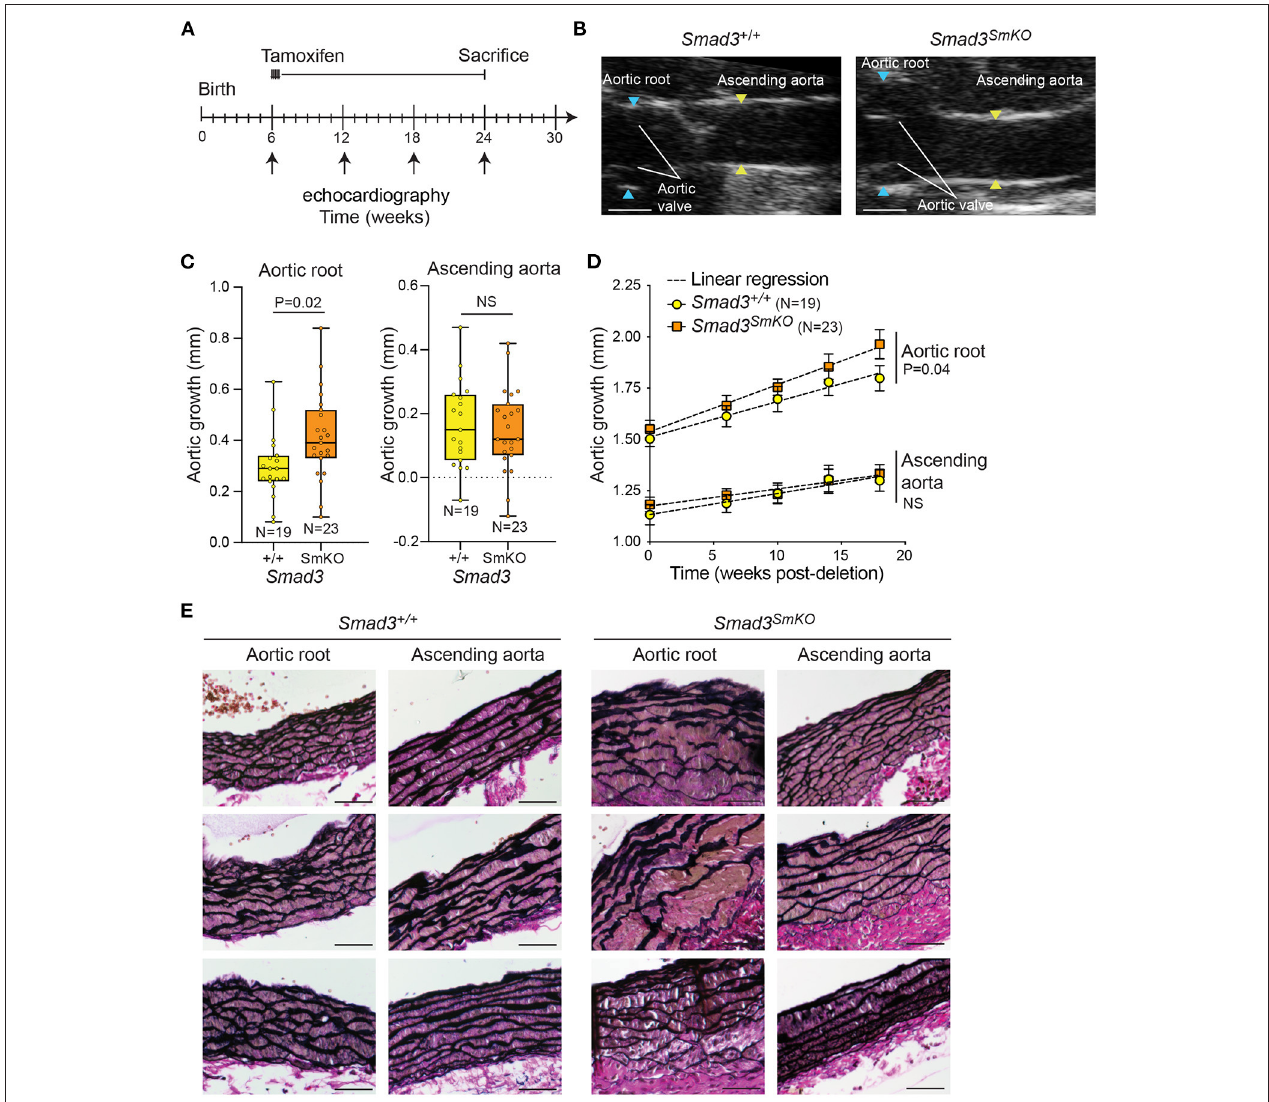
FIGURE 1 | Postnatal deletion of Smad3 in VSMCs induces significant dilation of the aortic root but not ascending aorta. (A) Schematic of postnatal Smad3 deletion in smooth muscle cells using Myh11-Cre ER . Tamoxifen was administered at 6 weeks of age and mice were sacrificed at 24 weeks of age. Tamoxifen - treated Smad3 flox / flox ;Myh11-Cre ER are referred to as Smad3 SmKO , while Tamoxifen - treated Smad3 + / + ;Myh11-Cre ER are indicated as Smad3 + / + . (B) Representative echocardiographic images of Smad3 + / + and Smad3 SmKO aortas at 24 weeks of age, blue arrows indicate aortic root dimensions and yellow arrows indicate dimensions of the ascending aorta. Scale bar is 1mm. (C) Aortic root and ascending aortic growth of control and Smad3 SmKO mice from 6 to 24 weeks of age as measured by echocardiography. P -value refers to two tailed Student’s t-test. (D) Aortic root and ascending aortic size of Smad3 SmKO mice measured by echocardiography at baseline and several intervals post-deletion. The dotted line indicates simple linear-regression, and P -value refers to an analysis of covariance comparing the two slopes conducted on Graphpad. (E) Representative sections of the aortic root and ascending aorta obtained from Smad3 + / + and Smad3 SmKO animals and stained with Verhoeff Van Gieson; three individual biological replicates per condition are shown. Scale bar is 50 µ